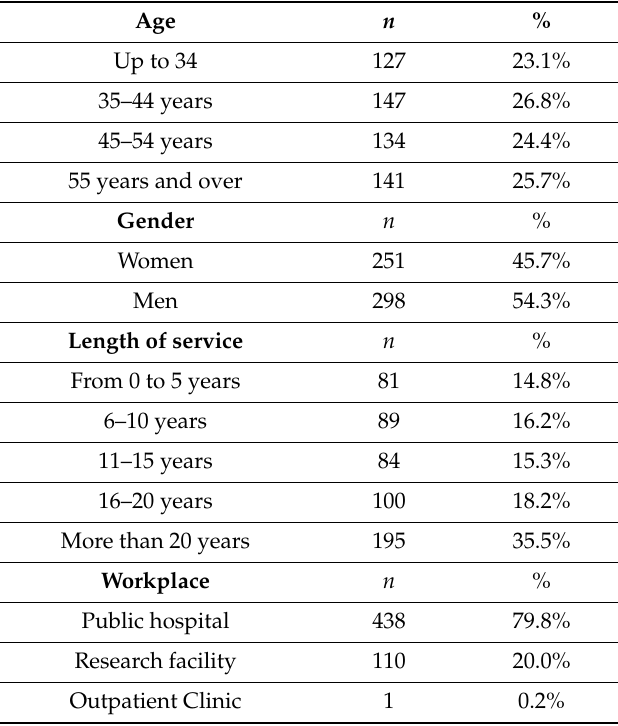
Table 1. Demographic data.